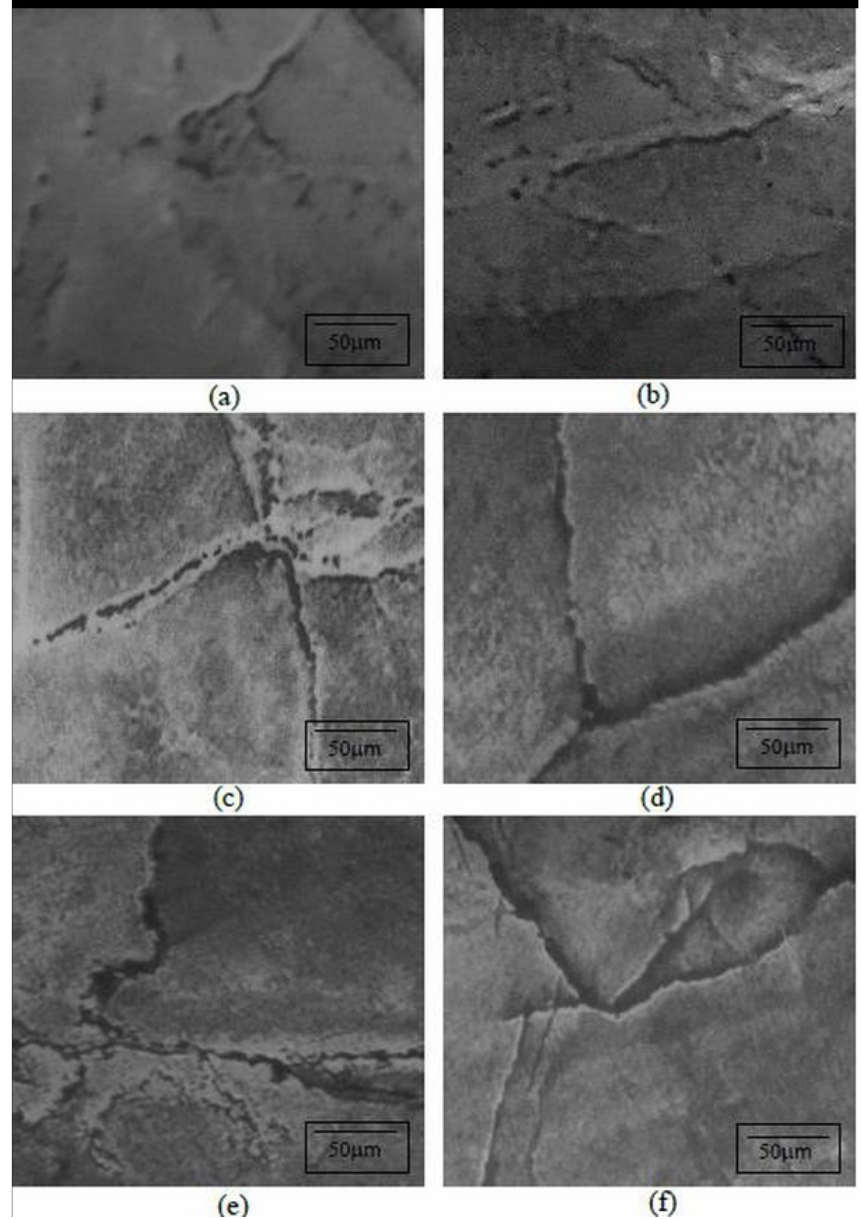
Figure 9. Hydrogen-assisted cracking on the fracture surfaces of the plasma-hydrogenated prestressing steel wire samples to: (a) 0%, (b) 30%, (c) 40%, (d) 50%, (e) 70% and (f)